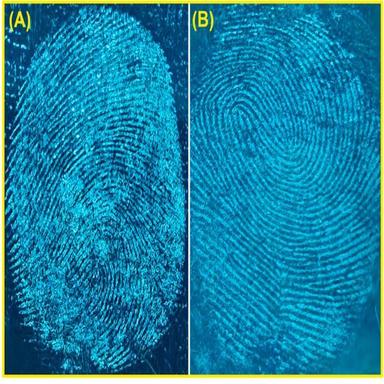
Visualization of latent fingerprint developed using SCD5 under UV illumination.